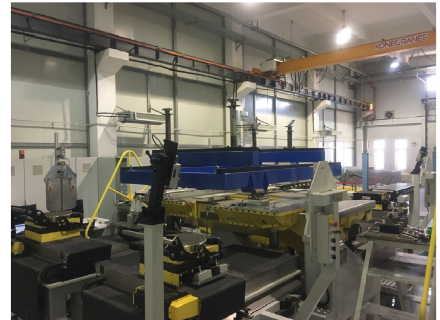
Figure 2: Separate measurement of the mounting base.